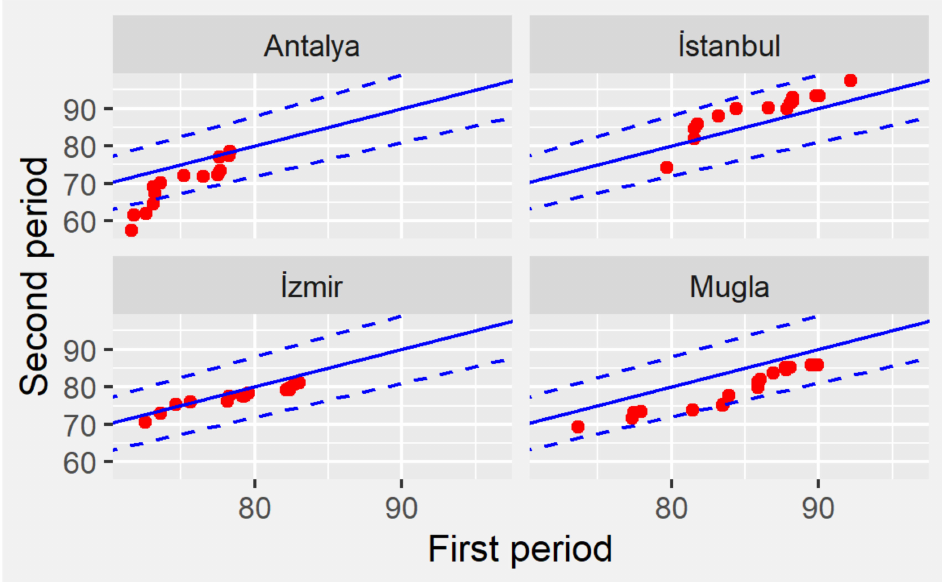
Figure 11. Sen trend analysis of TCI of